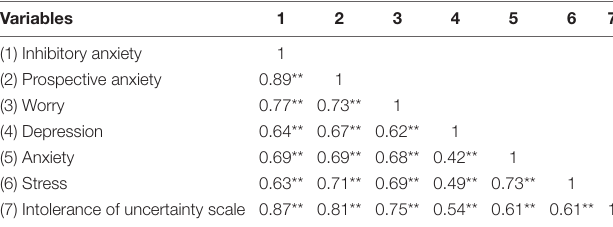
TABLE 4 | Correlations between the studied